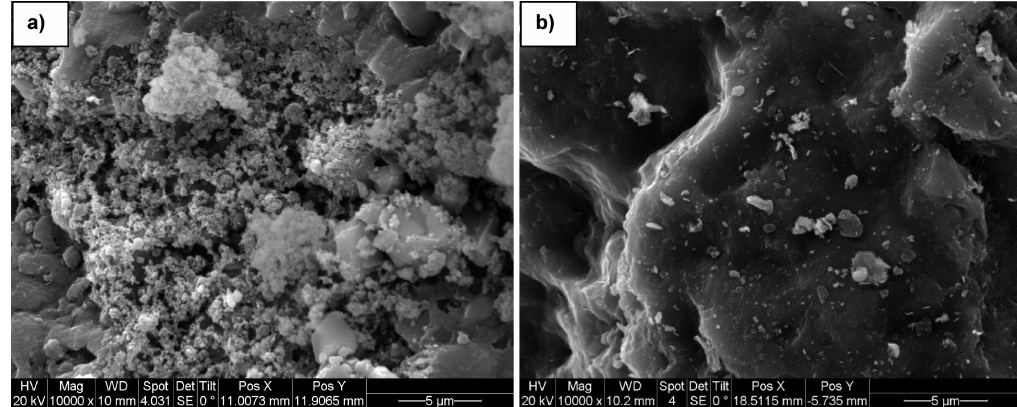
Figure 43. Environmental scanning electron microscope (ESEM) microphotographs of Ni-Mo-W nanoparticles deposited on low-permeability oil sands at the ( a ) top and ( b ) bottom of the reactor column at a temperature of 320 °C. Figure reproduced from Ref.